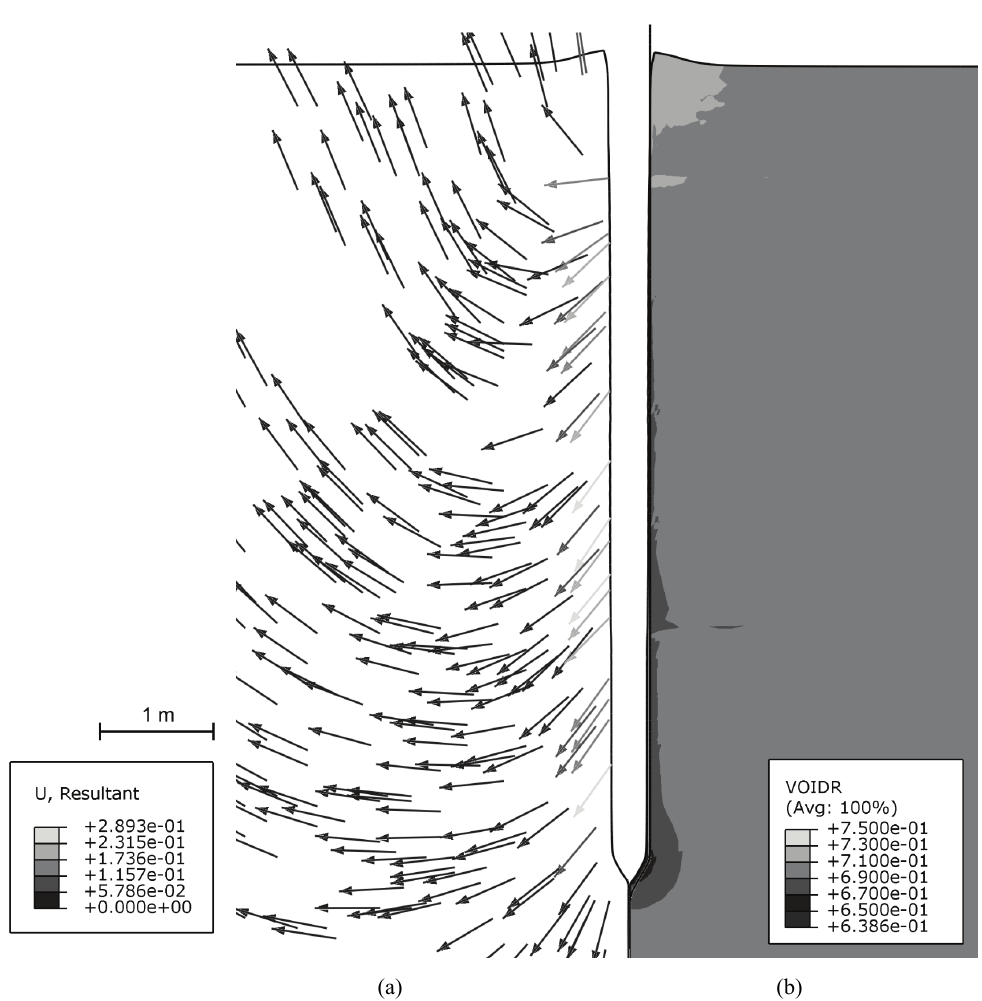
Fig. 11. (a) Displacement of soil around the pile and (b) void ratio change at the end of installation and consolidation